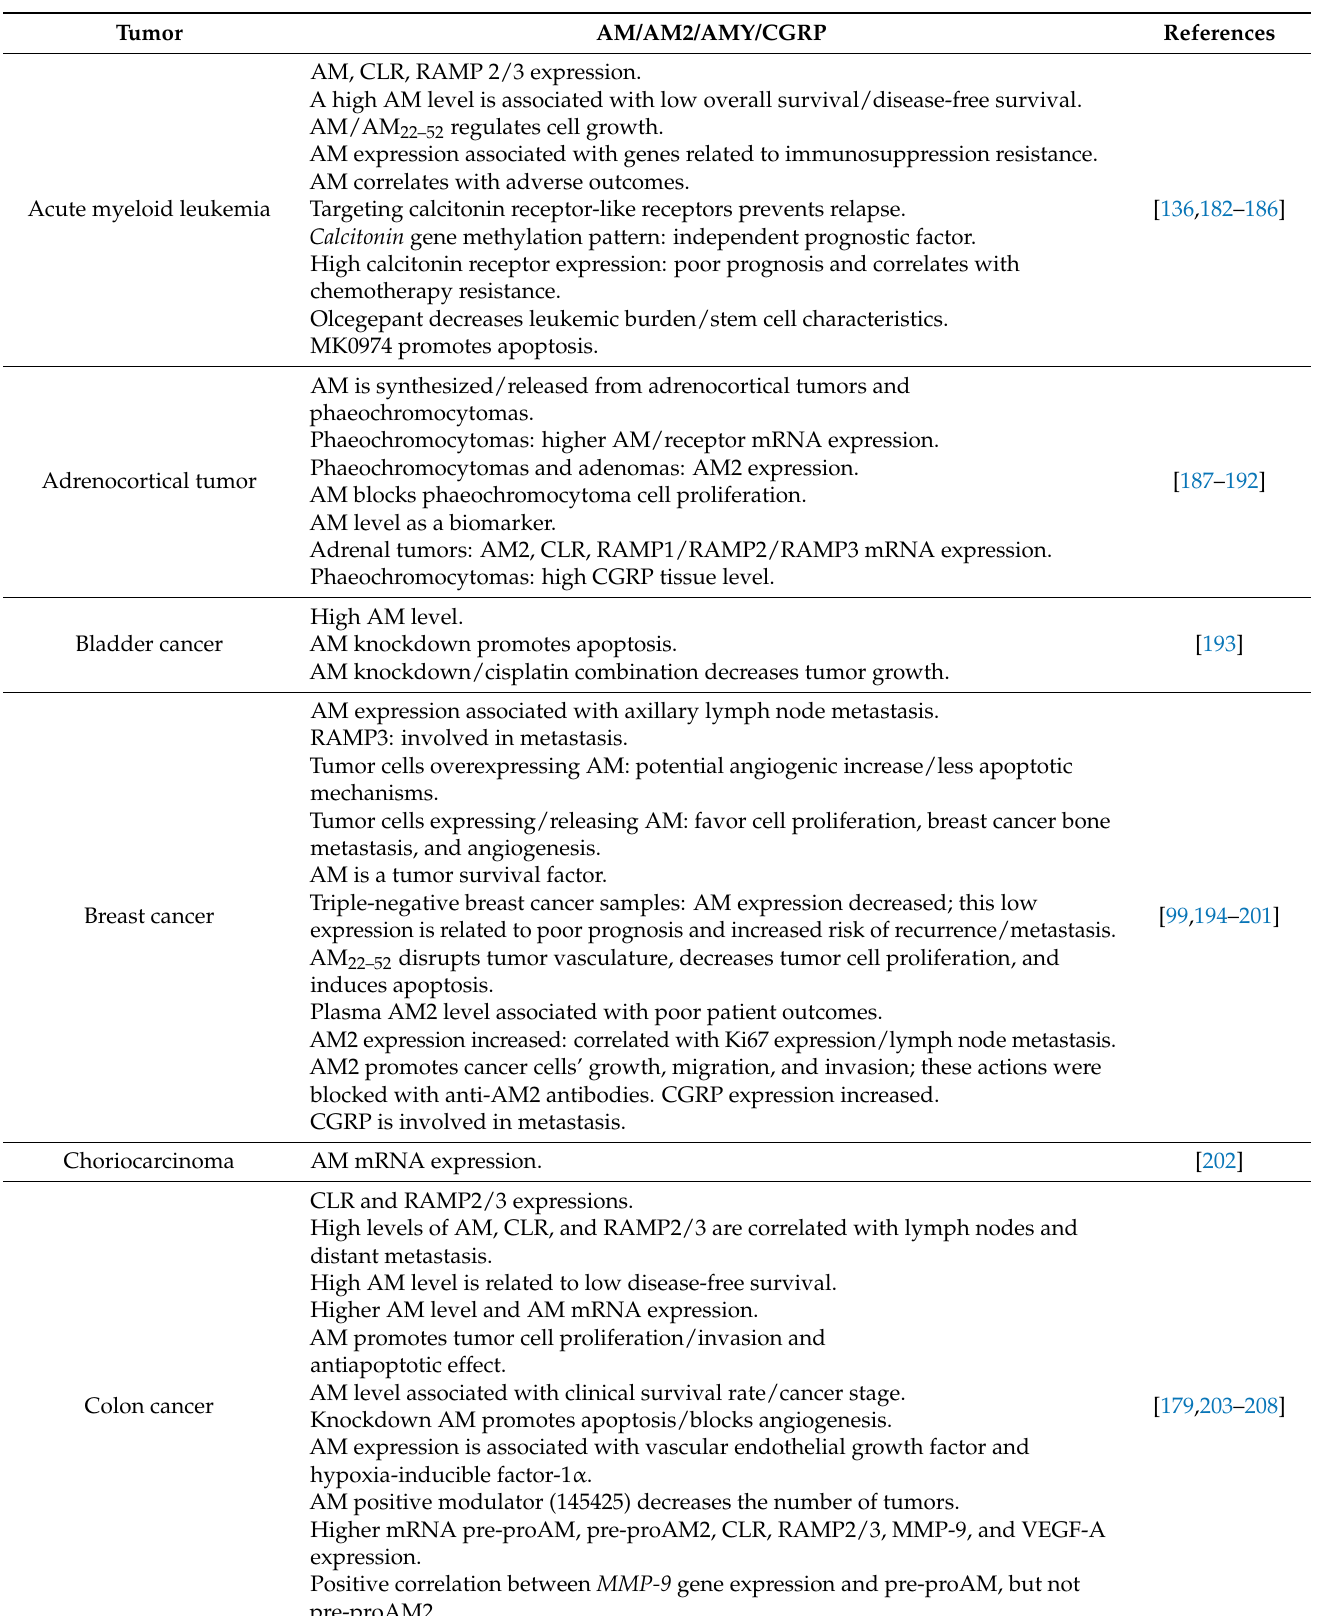
Table 2. Participation of adrenomedullin (AM), adrenomedullin 2 (AM2), amylin (AMY), and calcitonin gene-related peptide (CGRP) in